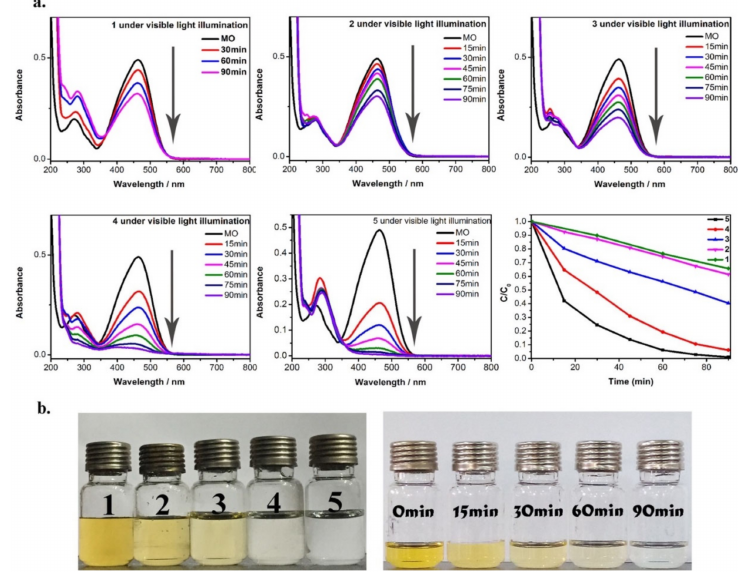
Figure 6. ( a ) Adsorption and photocatalytic degradations spectra of methyl orange dye using Zn and Co 2 + / Zn 2 + metal-doped MOFs (M(tpbpc)(bdc)0.5 · H 2 O) and ( b ) photographs of photocatalytic degradation of the dye using the MOFs under visible light irradiations. Reproduced with permission from Reference